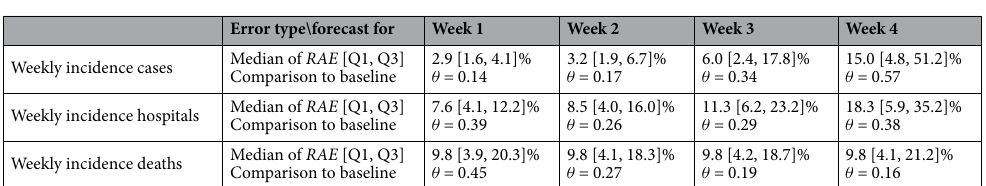
Table 2. Statistics of the forecast performance of our model in 2021. The first row in the data cells is the median of RAE with interquartile range in square brackets (1st and 3rd quartiles) and the second row is the relative performance of our model compared to the baseline model, measured by the ratio θ .